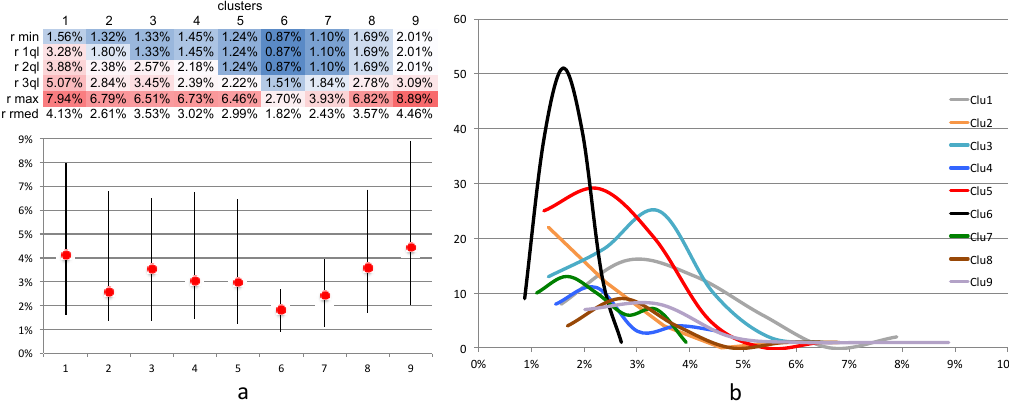
Figure 10. Cap rate by cluster: ( a ) range and quartiles; ( b ) probability density functions.